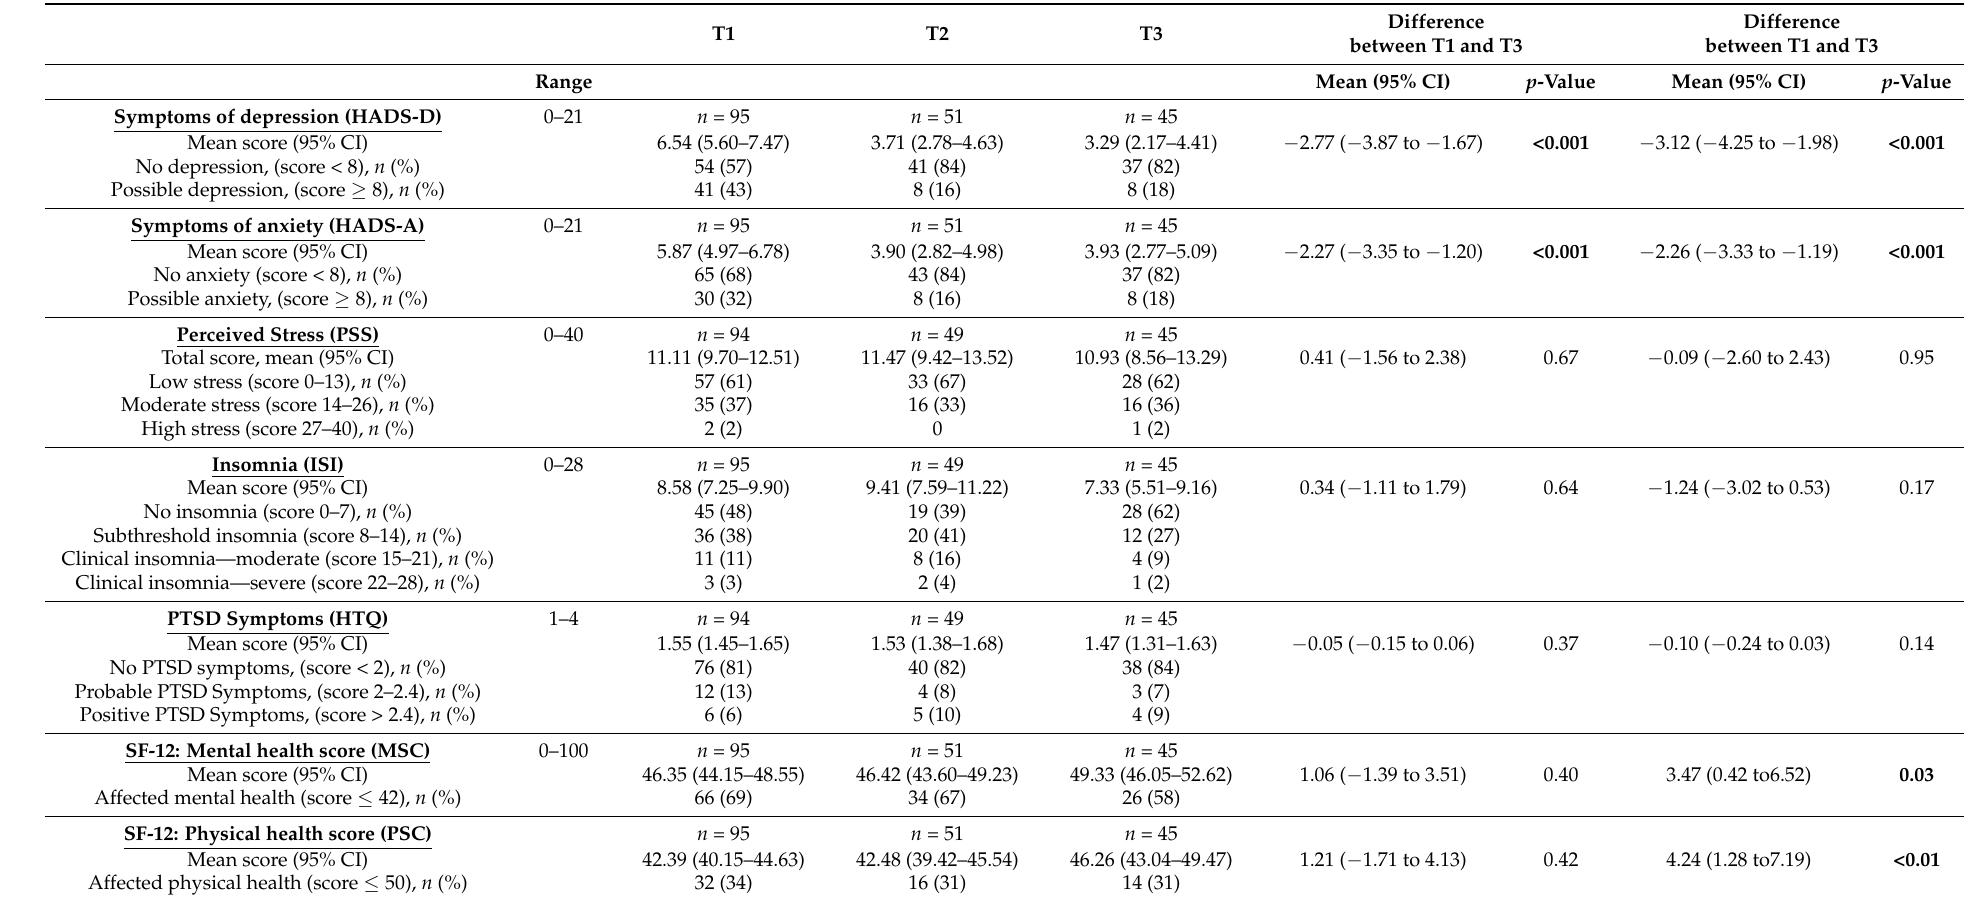
Table 2. Psychological distress outcomes over time among 95 admitted COVID-19 patients during May 2020–May